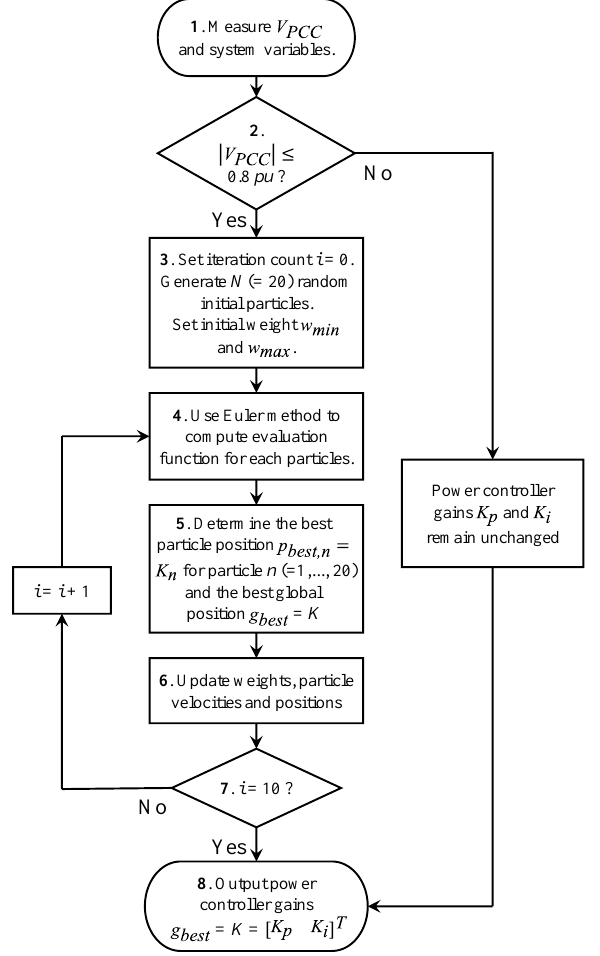
Figure 8. Flowchart for the procedure of adjusting gains K p and K i by particle swarm optimization (PSO) self-tuning real power controller.